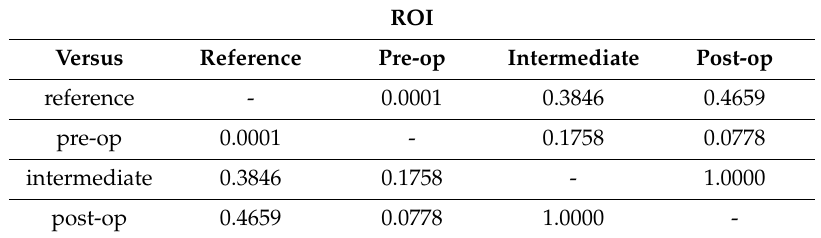
Figure 9. Fractal dimension values in ROI groups. Table 2. Results of Kruskal–Wallis one-way analysis of variance for fractal dimension analysis ( p -values).